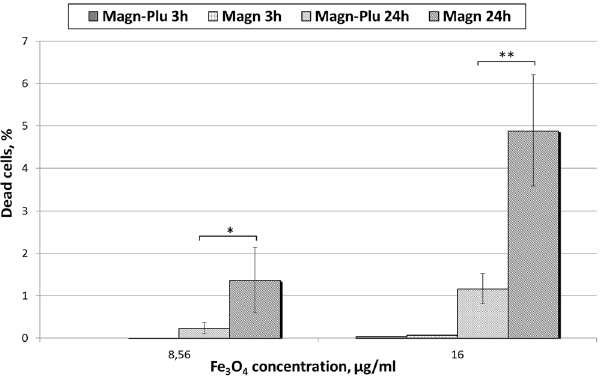
Figure 10. Histogram of apoptotic cells percentage in LNCaP cells population after incubation with Magn-Plu and Magn NPs for 3 h and 24 h. Results are shown as means ±